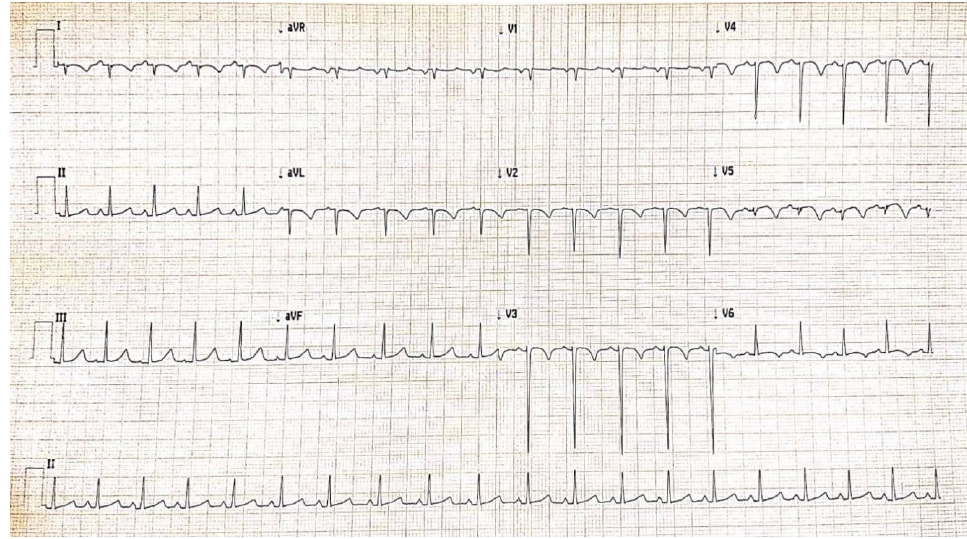
Figure 8. Electrocardiogram at